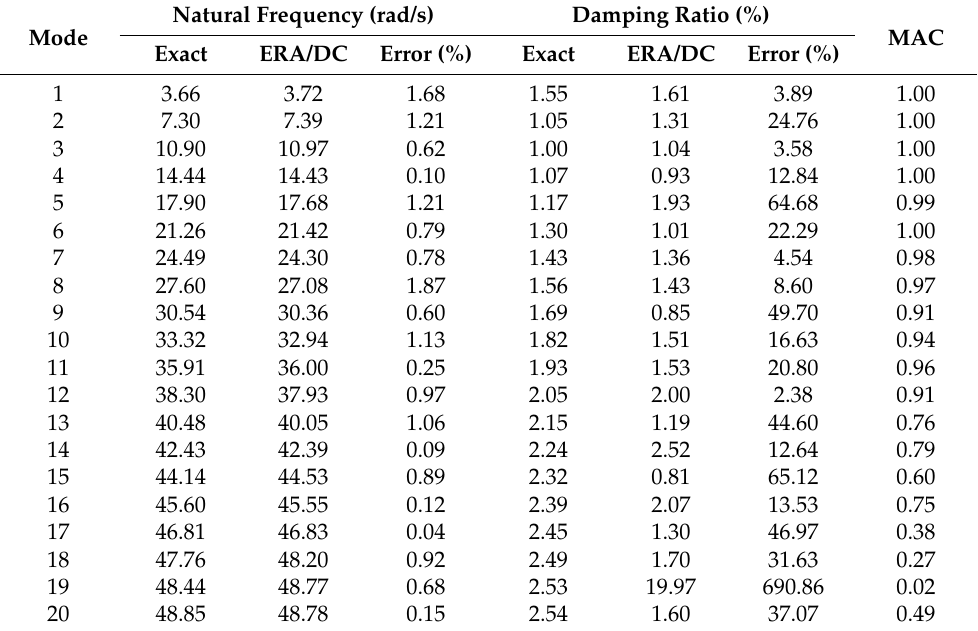
Figure 15. Stabilization diagram of 20-DOF chain model roughly showing the first 12 natural frequencies of the identified structural modes. Table 5. Modal parameter identification result of a 20-DOF system subjected to nonstationary white noise